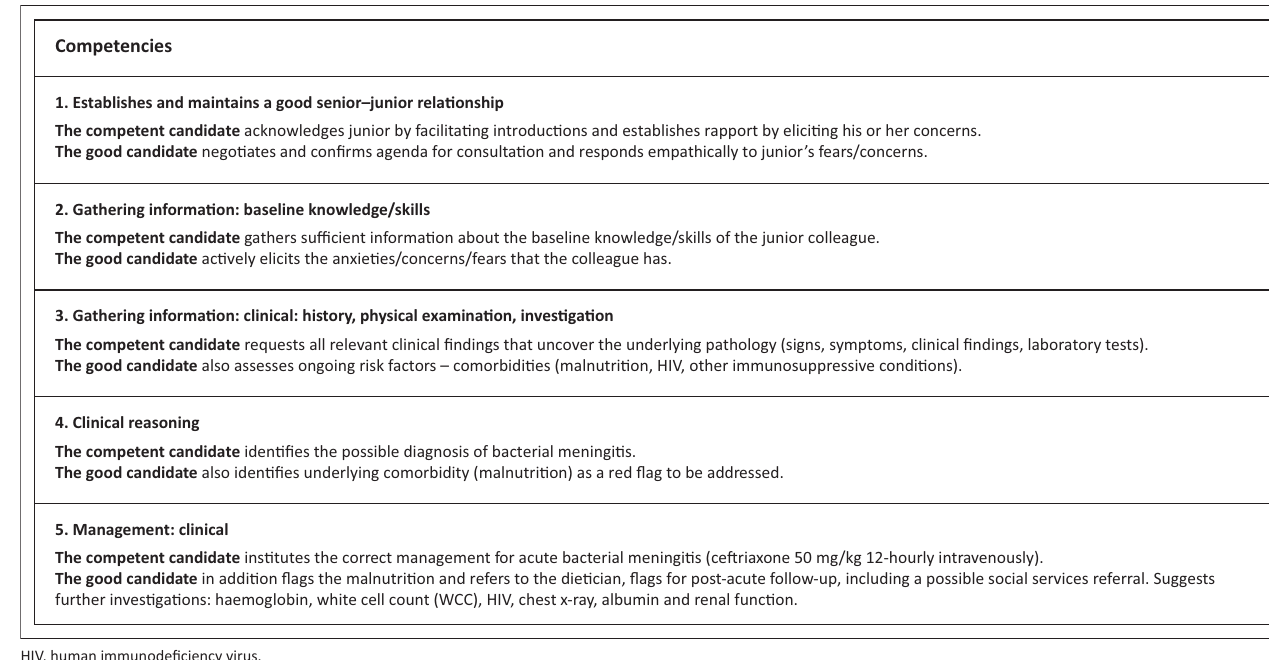
FIGURE 3: Guidelines for examiners to judge student